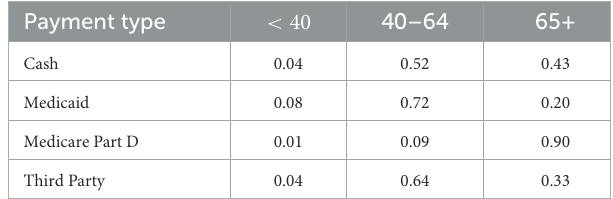
TABLE 1 Statin sales in 2019 and 2020 (January–August, in millions of daily